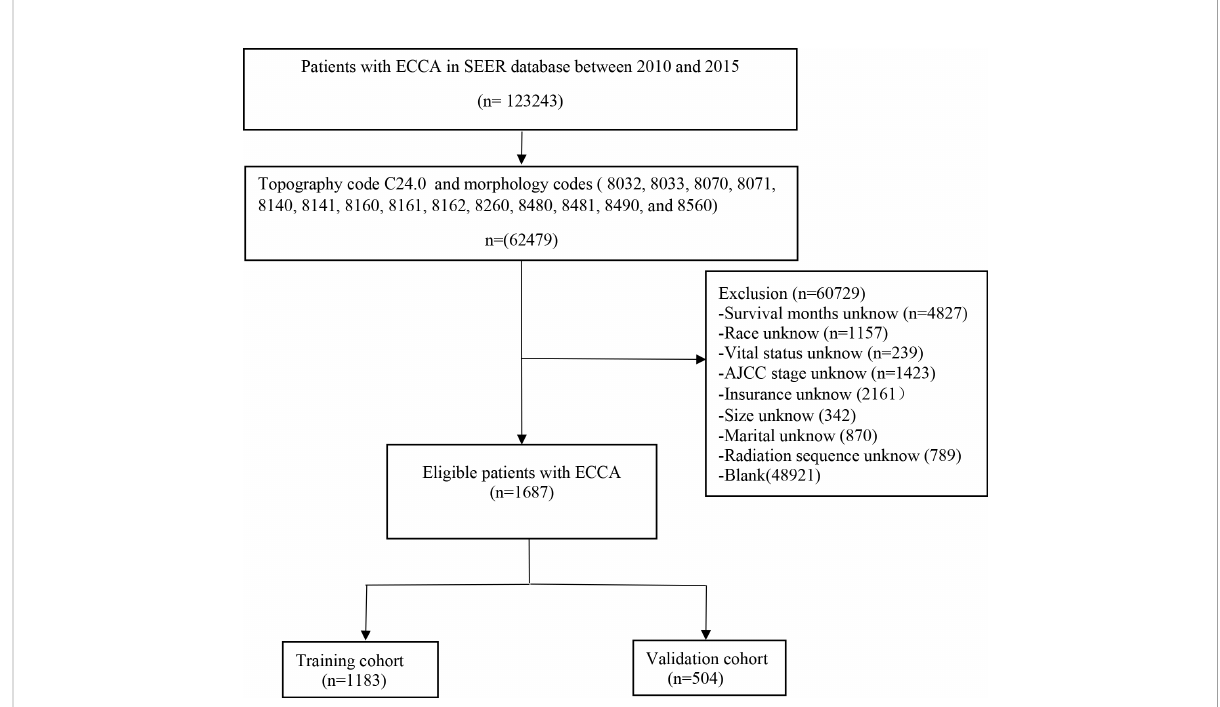
FIGURE 1 Flow diagram of the ECCA patients in the training and validation cohorts. ECCA: extrahepatic